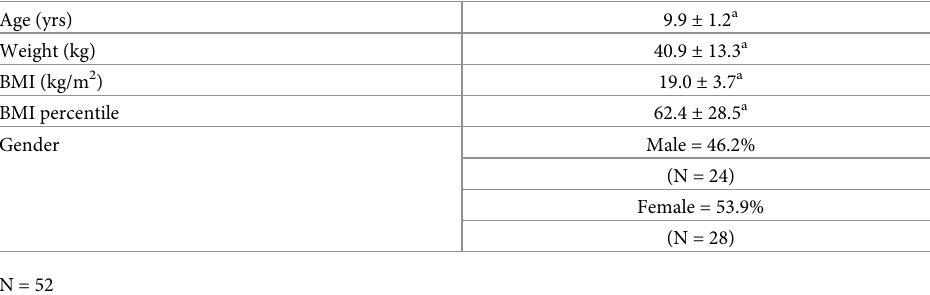
Table 1. Baseline